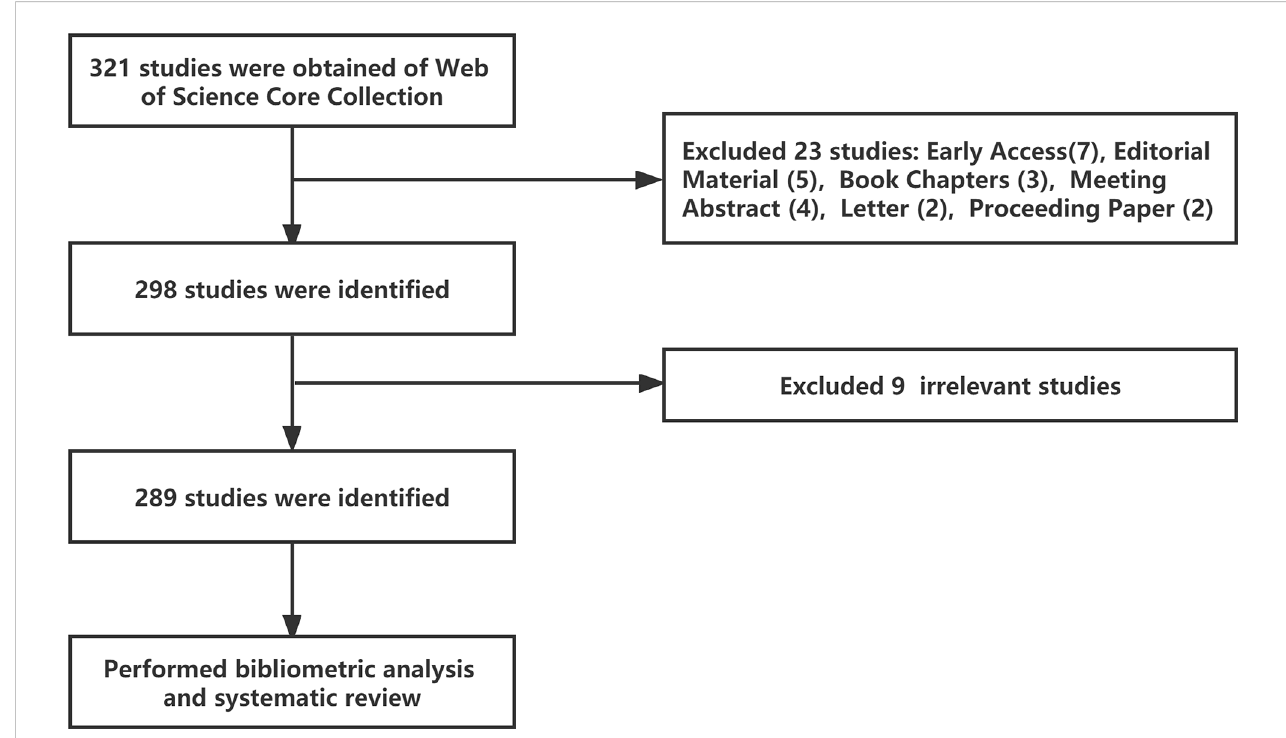
FIGURE 1 Article selection process for bibliometric analysis and systematic